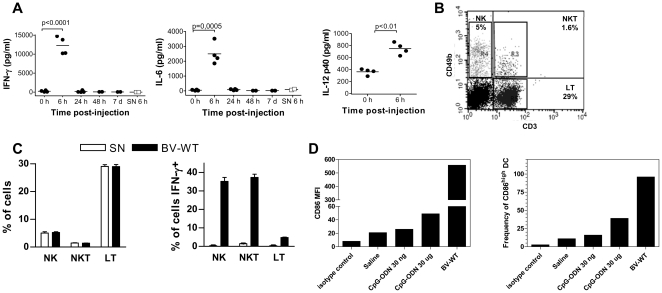
Innate immune response in mice injected with BV.(A) Induction of inflammatory cytokines by BV. C57BL/6 mice were i.v. injected with 5×107 PFU BV (•) or with supernatants of uninfected insect cells (SN, □), and at the times shown sera were collected and assayed for IL-6, IFN-γ and IL12p40 by ELISA. Sera collected before the injection were employed as control. Results are representative of two independent experiments. The line depicted in each group corresponds to the mean of each group of dots. (B, C) Activation of NK, NKT and T cells by BV. C57BL/6 mice were i.v. injected with 5×107 PFU BV, and 3 hours post injection splenic populations were incubated in the presence of BFA for an additional 6 hours. Then, cells were labeled for CD49b and CD3 markers and intracellular IFN-γ. (B) A representative dot plot of the proportion of NK (CD49b+ CD3-), NKT (CD49b+ CD3+) and T (CD49b- CD3+) cells in the spleen of a control mouse and (C) the percentage of NK, NKT and T cells (left) and proportion of IFN-γ+ NK, NKT and T cells after BV injection (right) are shown. Results are representative of two independent experiments and are expressed as mean +/− SEM (n = 4). (D) In vivo maturation of DCs by BV. C57BL/6 mice were injected i.v. with saline, 5×107 PFU BV-WT and 30 ng or 30 µg CpG-containing oligodeoxinucleotide (CpG-ODN) 1826. Eighteen hours later, their CD11c+ spleen cells were labeled with anti-CD86 and analyzed on a FACSCanto II flow cytometer. In all cases, a minimum of 2×105 events was acquired. Results are representative of two independent experiments and are expressed as the geometric mean of the fluorescence intensity (MFI) and as the frequency of CD86+ cells in total DCs. Results are representative of at least two independent experiments.